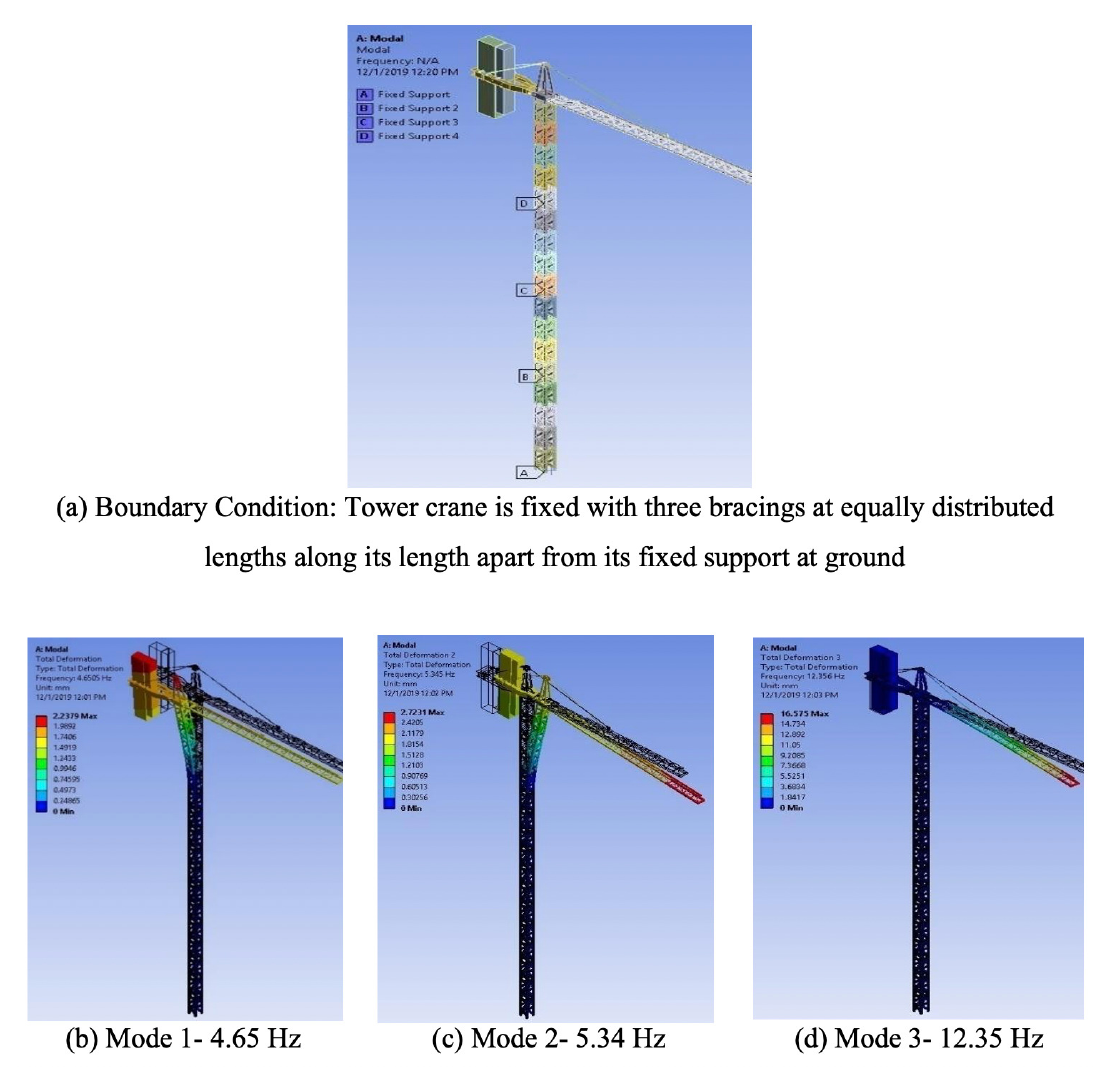
Figure 12. Modal parameters of tower crane with second boundary condition the other parts of the tower crane, and variation in the mo- ment of